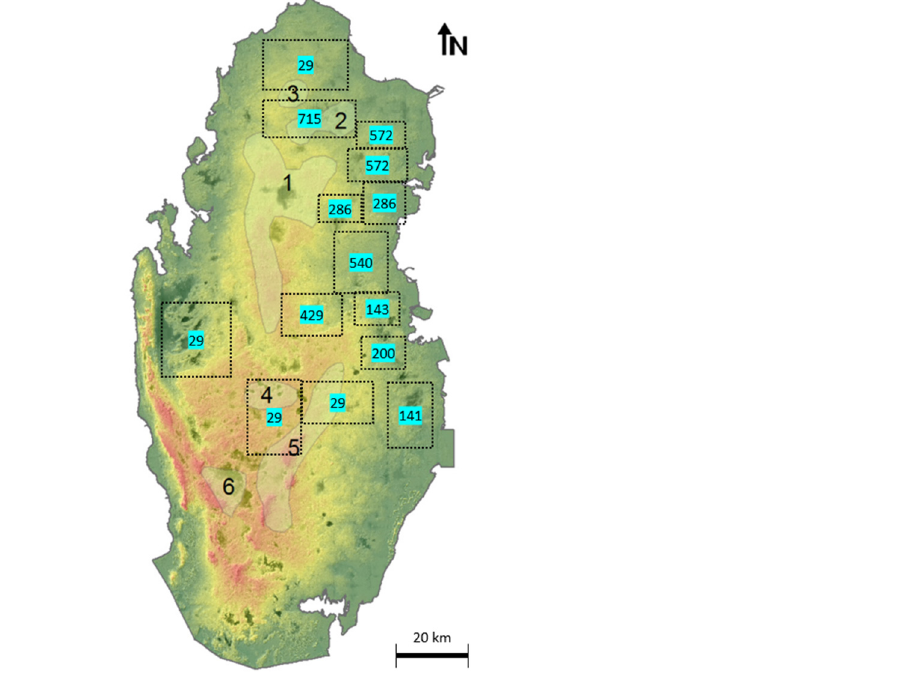
Figure 5. Zonation of the groundwater recharge [15] and pumping well locations (the number of wells is indicated within each zone).